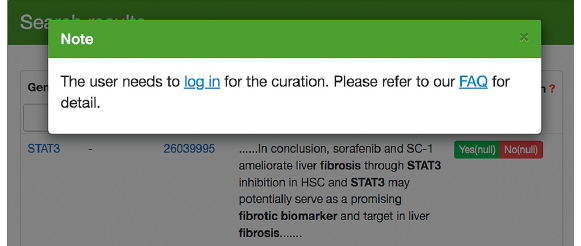
Figure 4: All logged-in users can give their feedback by clicking the “Yes” or “No” button to confirm or reject the evidence